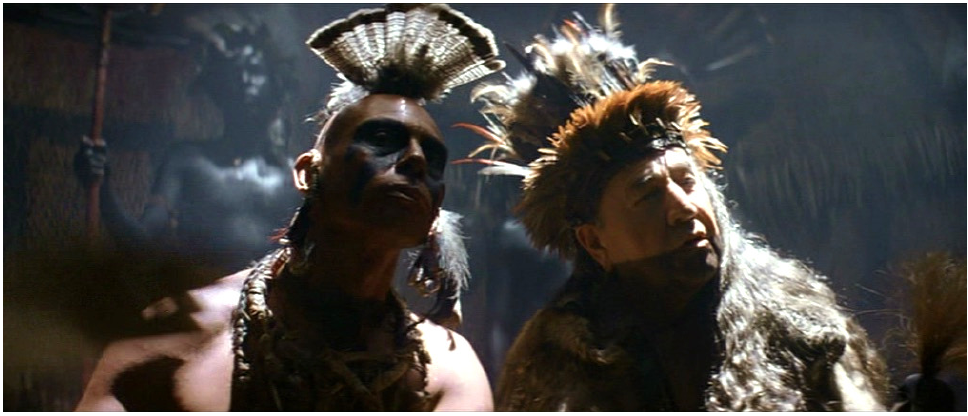
Figure 19: The tribesmen scrutinise their unprecedented visitor,